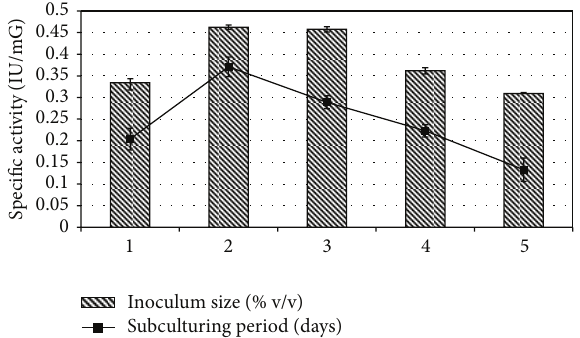
Figure 6: Effect of inoculum size and subculturing period on enzymeproduction.Resultsareexpressedasthemean ± S.D( 𝑛 = 3 ), 𝑃 -value <